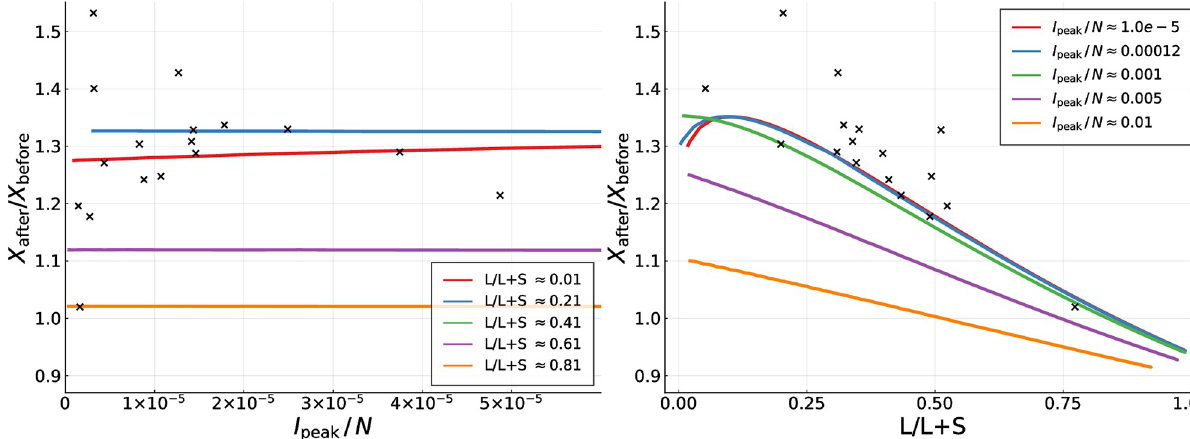
Fig 6. Fatalities before and after the peak—theory. For a fixed g 0 = 1.25, this plot reveals simulation results (solid lines) and estimates from the data (crosses) for the ratio of average fatalities after and before the infection peak, X after / X before . Compare Fig 5. A large number of simulations of the controlled SIR model have been performed over a range of α peak, I peak / N , and of the percentagewise contribution L /( L + S ) of long-term control. For most countries I peak / N is typically of the order of 10 − 4 or